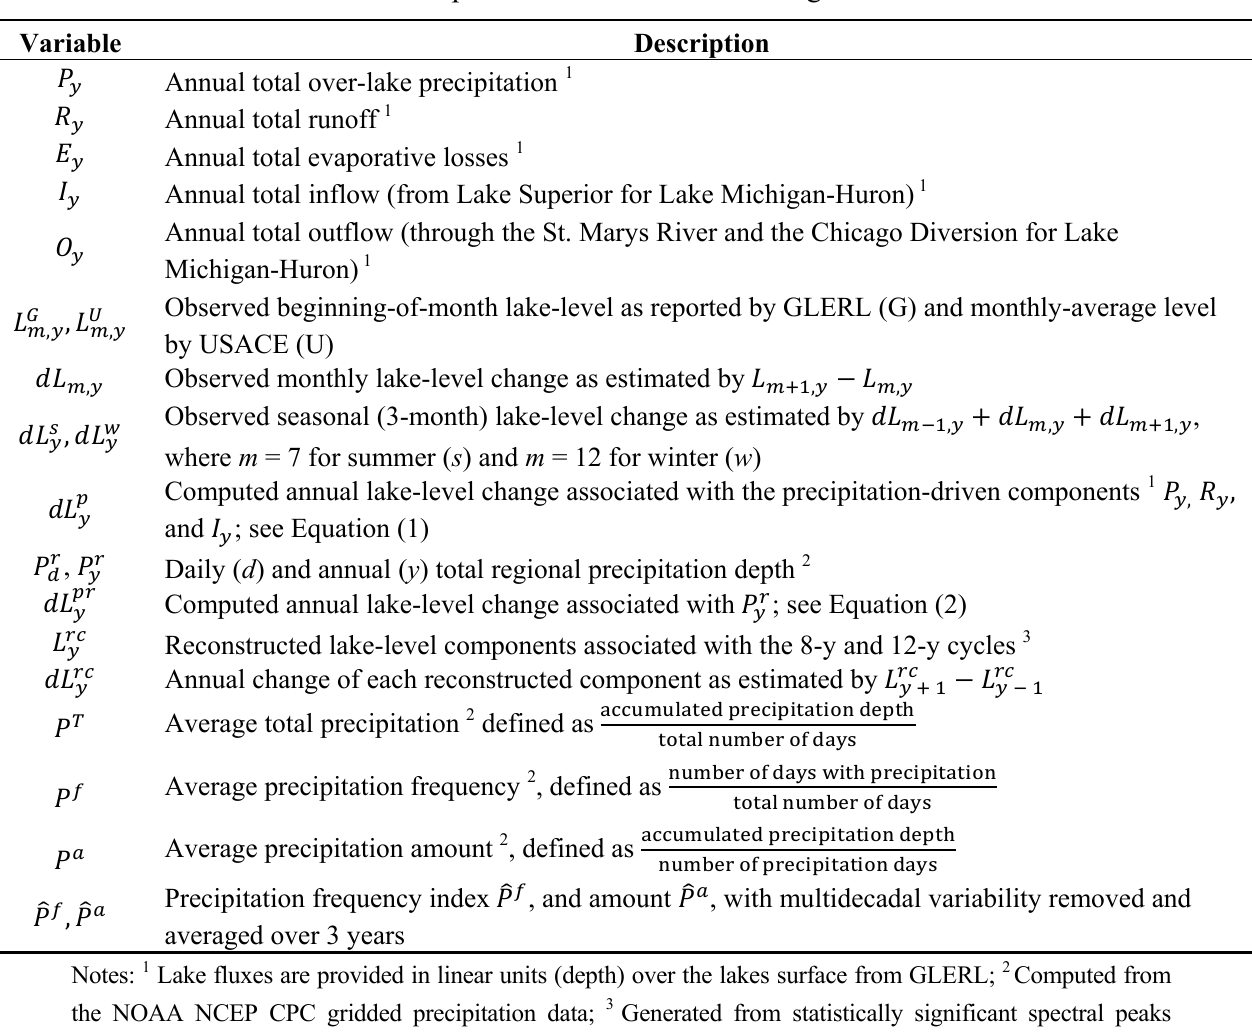
Table 1. Descriptions of variables used throughout the